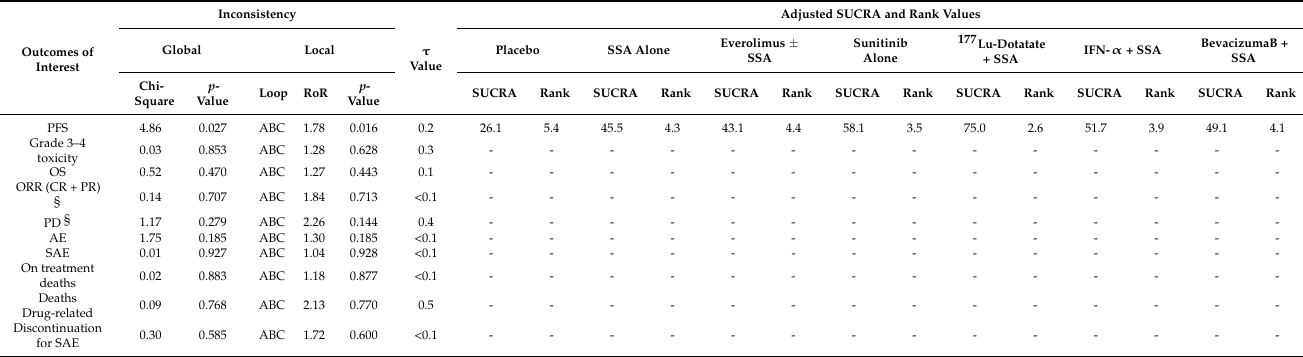
Legend: RoR = rate of odds ratio; SSA = somatostatin analogue therapy; Lu = Lutetium; IFN- α = interferon alfa; PFS = progression-free survival; OS = overall survival; SSA = somatostatin analogue therapy; AE = adverse event defined according to National Cancer Institute Common Terminology Criteria for Adverse Events; SAE = severe adverse event defined according to National Cancer Institute Common Terminology Criteria for Adverse Events; Lu = Lutetium; ORR = objective radiological response; CR = complete response; PR = partial response; PD = progressive disease; § = evaluated according to Response Evaluation Criteria In Solid Tumors; - = not